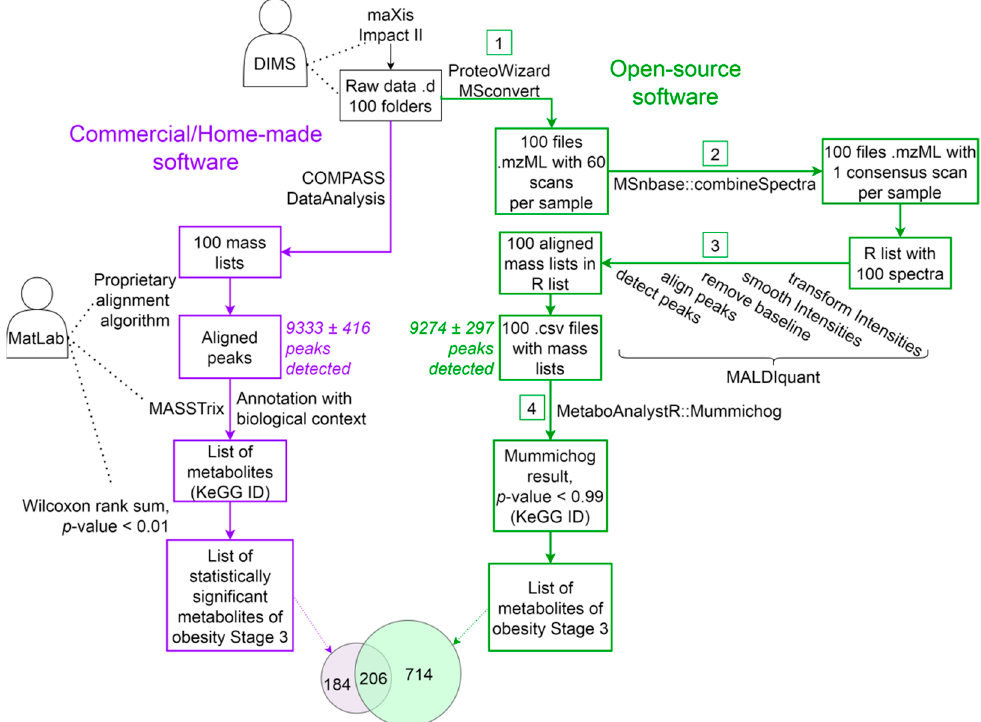
Figure 1. The order of launching programs for processing DIMS (ESI-QTOF, maXis Impact II, Bruker Daltonics) mass spectra. On the left (purple), a pipeline with the commercial COMPASS DataAnalysis program, and the MatLab development environment is shown. On the right (green)—the MALDIquant package together with MetaboAnalystR/Mummichog R language module. The numbers in the squares indicate the data processing steps described in the text.